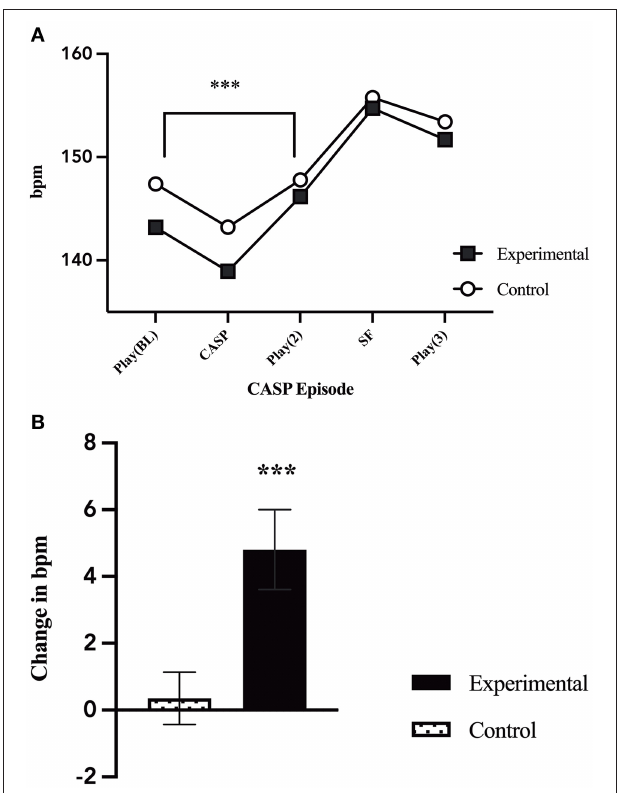
FIGURE 3 | Changes in infant heart rate. (A) Infant average heart rate throughout the five CASP episodes by group. There was a significant increase in heart rate from play 1 (E1) to the second play (E3) for infant’s who’s mothers were in the caretaker-stress condition [ F (1, 102) = 9.81, p = 0.002]. (B) Comparison of the change in infant average heart rate during play 1 (E1), before caretaker manipulation, and play 2 (E3), after the caretaker manipulation, by group (caretaker-stress or caretaker control condition) [ F (1, 102) = 9.81, p = 0.002]. p < 0.01***.